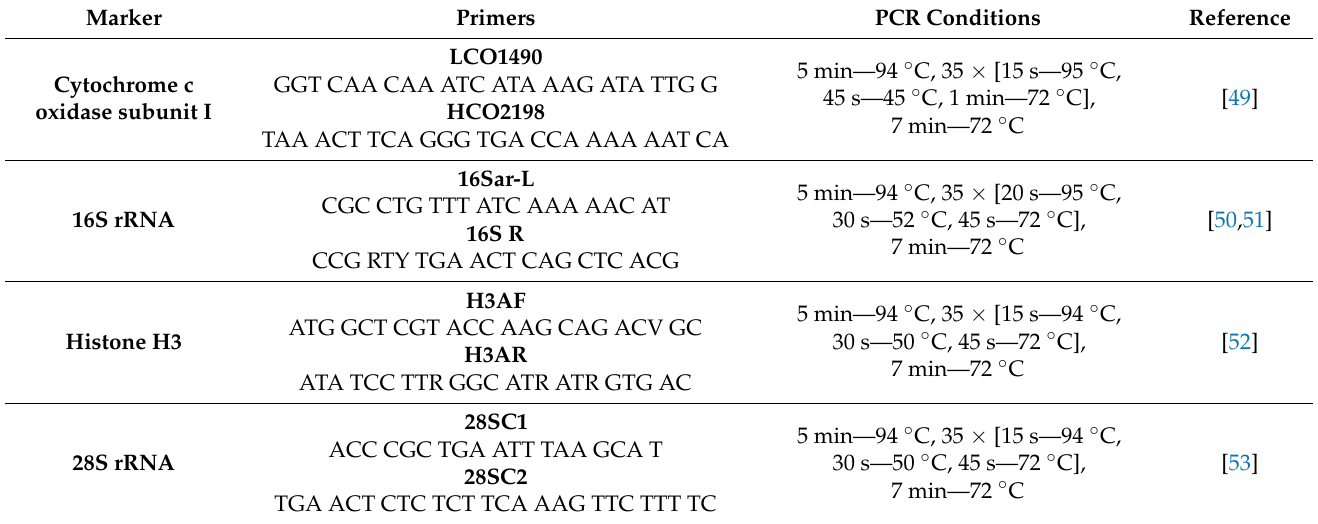
Table 1. Amplification and sequencing primers and PCR